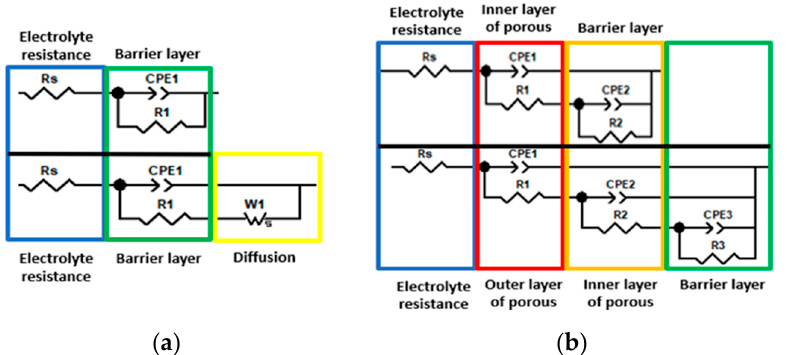
Figure 11. Equivalent Randle circuits used for the interpretation of EIS spectra recorded on Ti6-Al- 4V alloy ( a ) uncoated ( b ) coated by (up) PEO (down) hybrid PEO. alloy ( a ) uncoated ( b ) coated by (up) PEO (down) hybrid PEO.